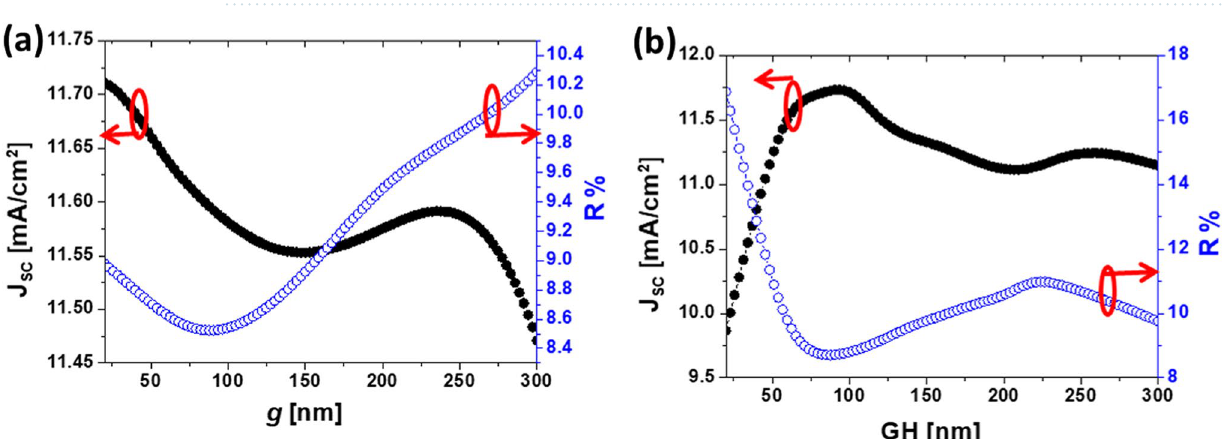
Figure 4. Variation of the short circuit current, J SC , and reflectivity, R , as a function of the gap distance, g , ( a ), and as a function of the height of the dimer elements, GH , ( b ). The material of the dimer structure is GaP. The reflectance is calculated for the spectral range between 300 and 800